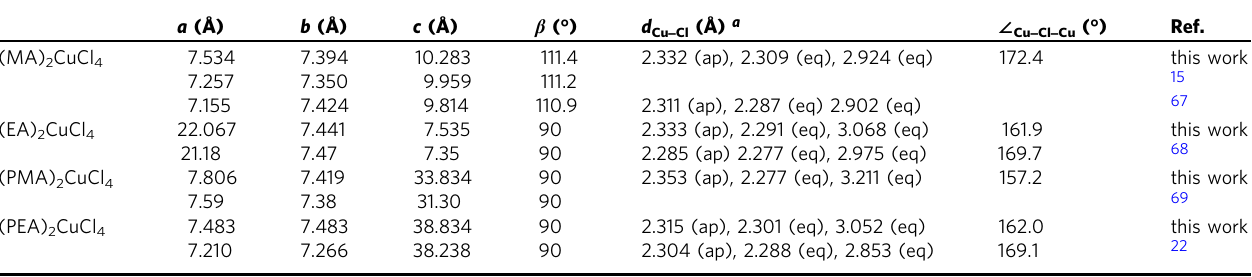
a ap and eq stand for apical and equatorial bonds, respectively. The referenced experimental values are also shown for comparison.